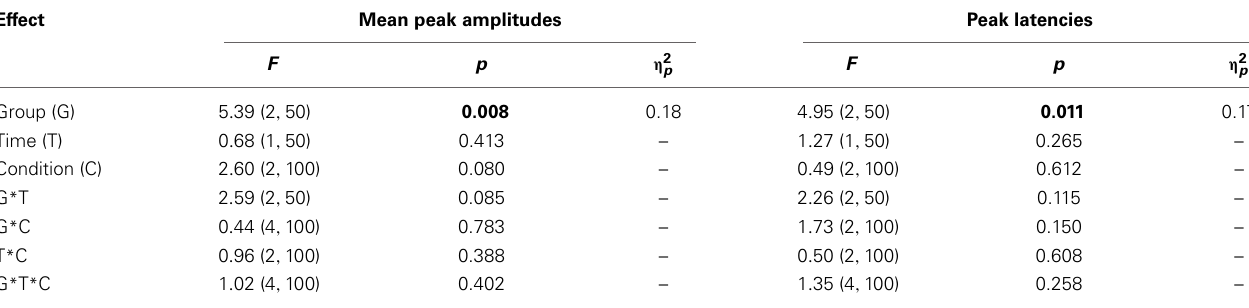
Table 2 | Results of the ANOVAs for repeated measures with F -values (df), p -values, and effect sizes η 2 p for the N400 mean peak amplitudes and latencies including the between-subject factor group (CON; IMP; NIMP) and the within-subject-factor time (pre; post) and condition (W; PH;